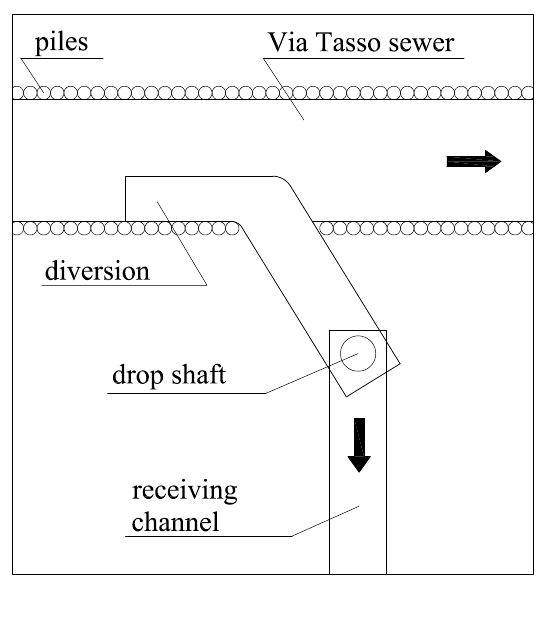
Figure 1. Schematization of the area of